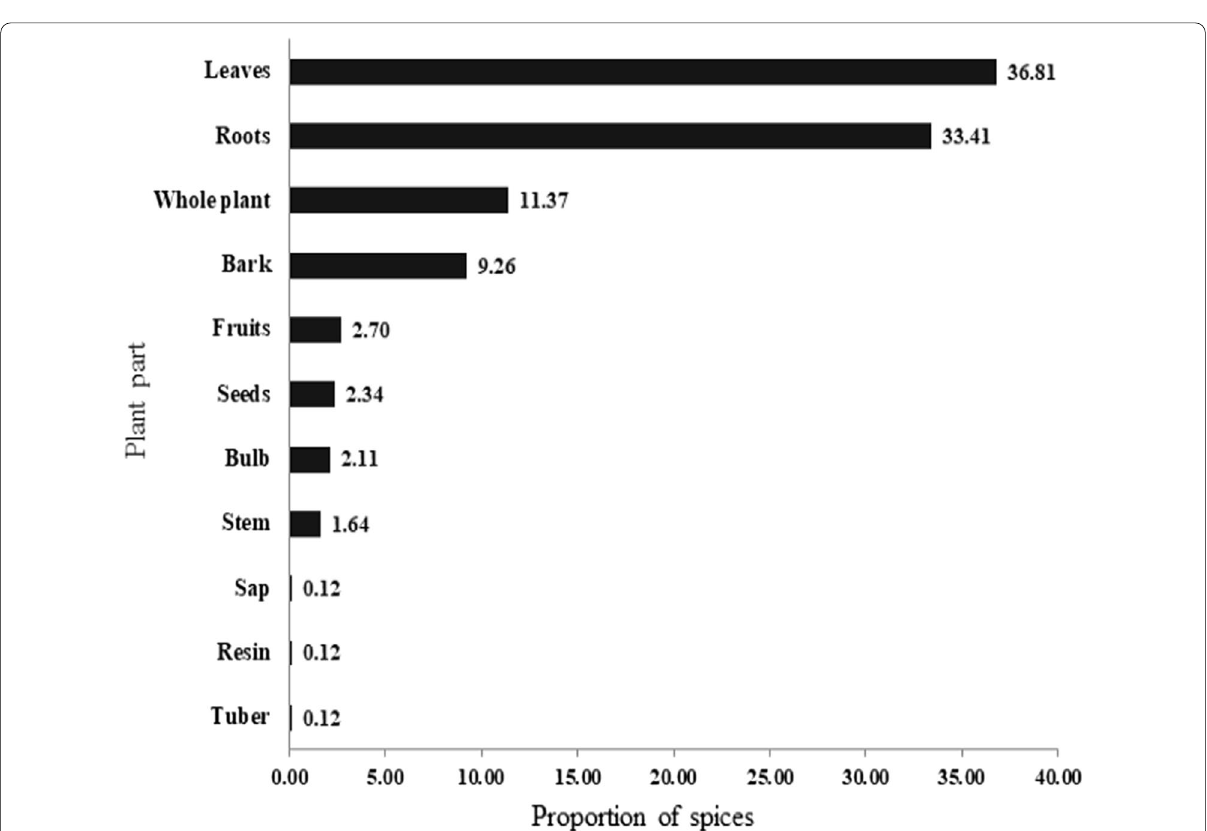
Fig. 4 Parts of plants used in preparation of anti-snakebite recipes in